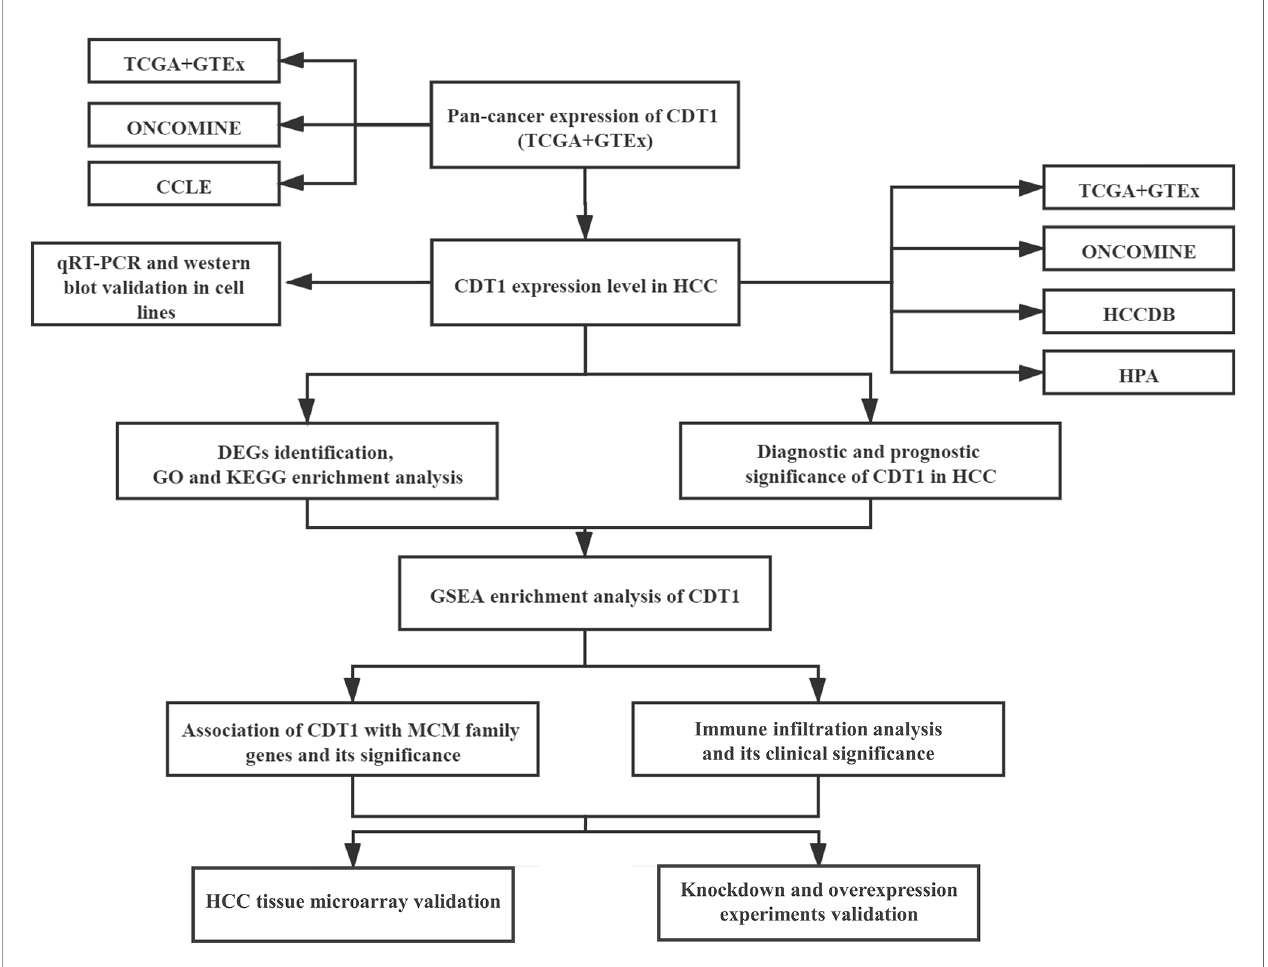
FIGURE 1 | The work fl ow of the